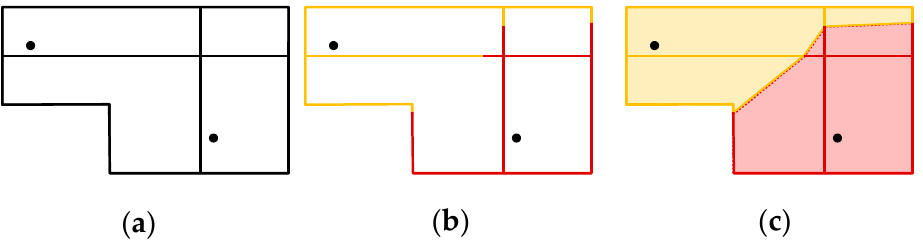
Figure 3. Construction of network Voronoi diagram and network Voronoi polygons: ( a ) point cluster and the road network related to them; ( b ) the network Voronoi diagram of the points; and ( c ) the network Voronoi polygons of the points.